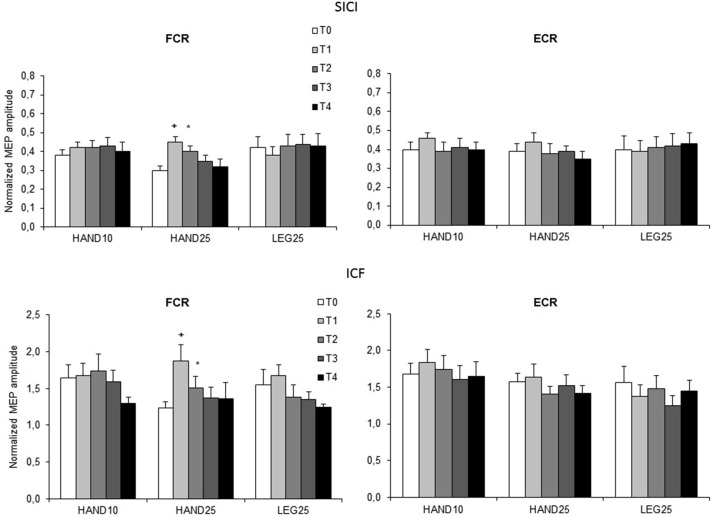
Normalized paired-pulse responses at baseline (T0), immediately after (T1), 0.5 h (T2), 1 h (T3) and 2 h (T4) after 20 min rPMS. Upper plots represent the results of both muscles for interstimulus intervals (ISI) of 3 ms (SICI), lower plots represent the results for ISI 13 ms (ICF). Values are normalized for each subject to their corresponding values in single pulse stimulation and plotted as mean (SEM). The significant differences between T0 and the corresponding post stimulation assessment are presented (*p < 0.05; +p < 0.01).